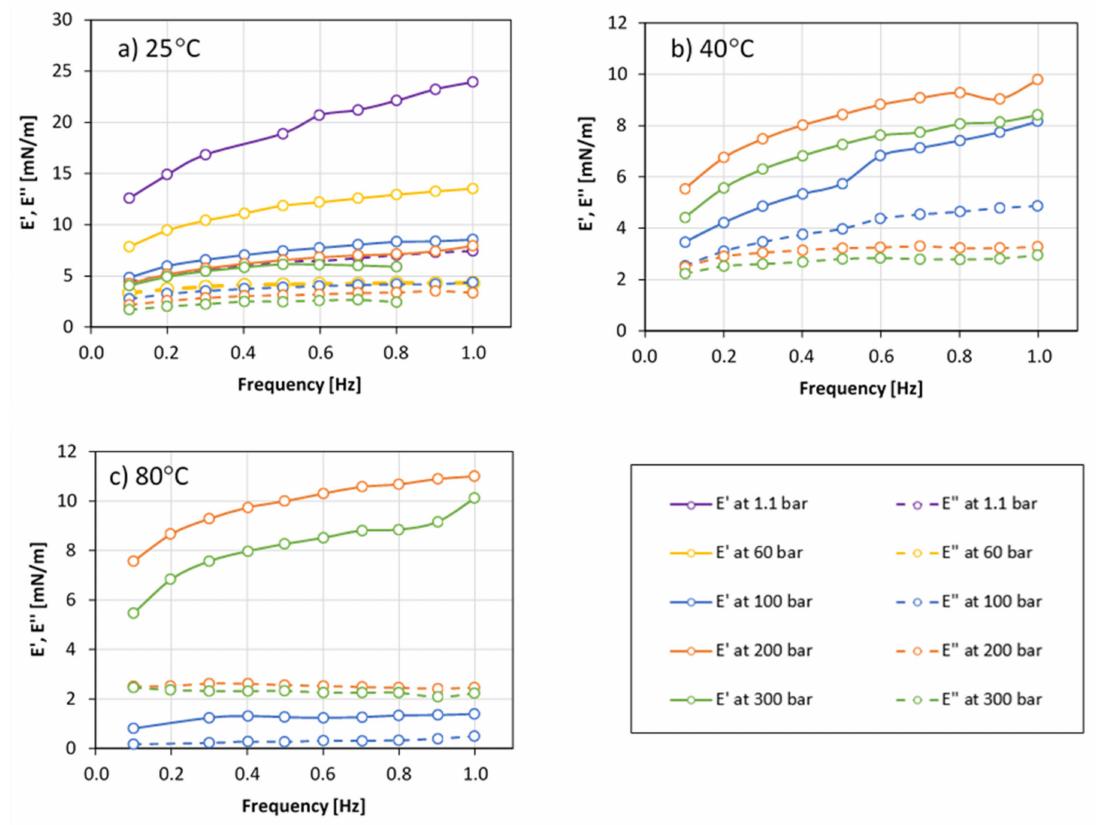
Figure 3. Apparent complex elastic modulus ( E (cid:48) ) and viscous modulus ( E ”) at pressures from 1.1 to 300 bar for temperatures of ( a ) 25 ◦ C, ( b ) 40 ◦ C and ( c ) 80 ◦